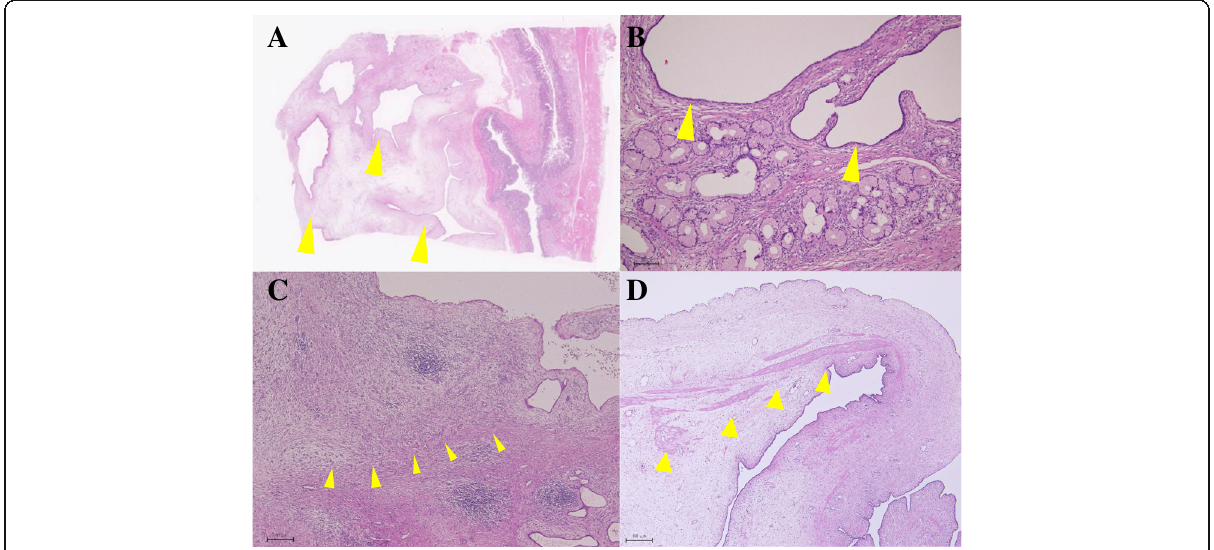
Fig. 6 Heterotopic glands (arrow) and stroma was found in the SM layer ( a ) and delated grands (arrow) was found ( b ). Edematous stroma and inflammatory cells were found in SM layer ( c ). Smooth muscle bundles were found around the grands (arrow) ( d